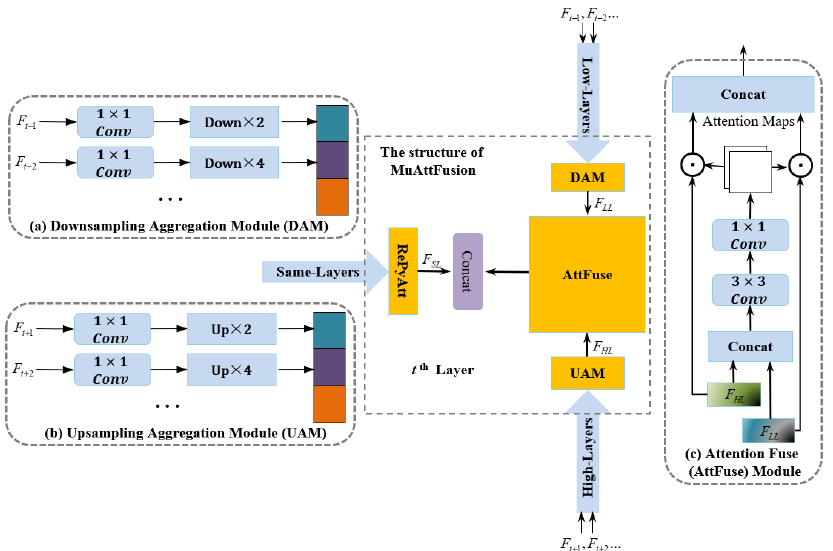
Figure 4. Proposed MuAttFusion module. It selectively fuses the same-layer, higher-layer, and lower-layer features using an adaptive attention